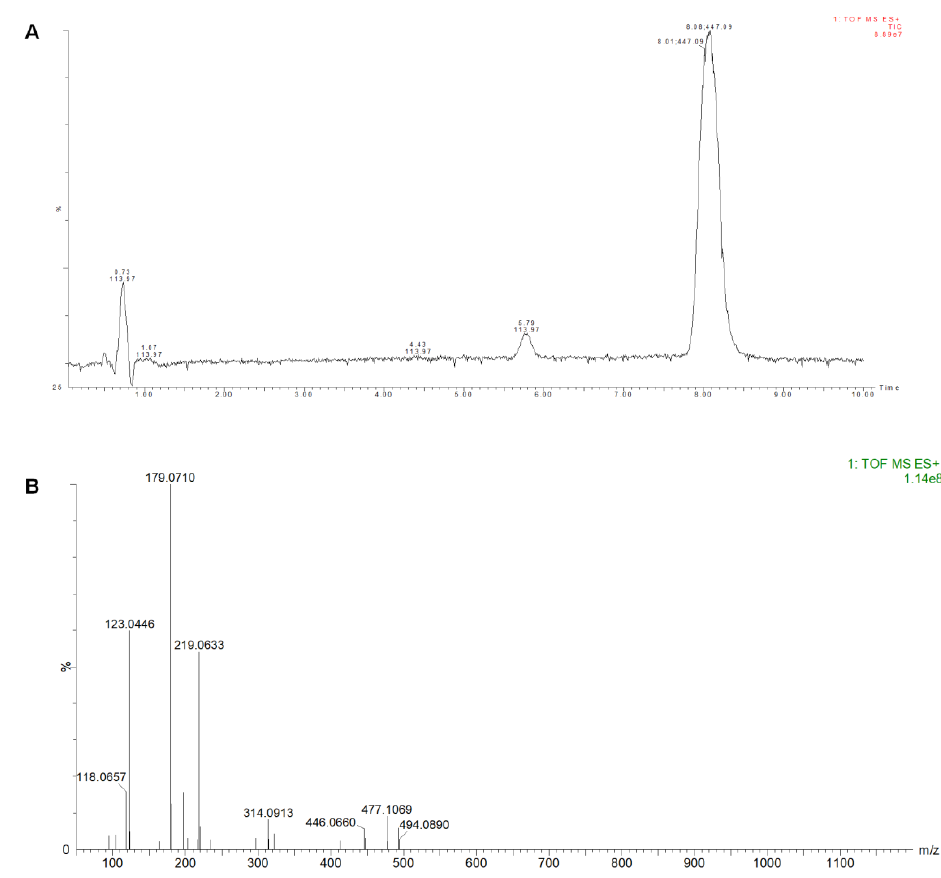
Figure 10. The mass spectra of component P3. ( A ) is the total ion chromatogram; ( B ) is the primary mass spectrum in positive ion mode.